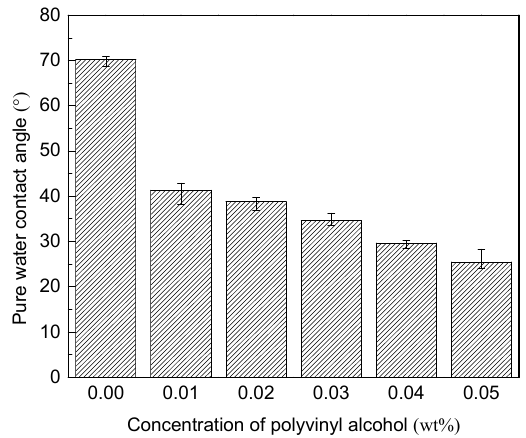
Figure 8. Pure water contact angle of MWCNTs/PVDF conductive membrane.